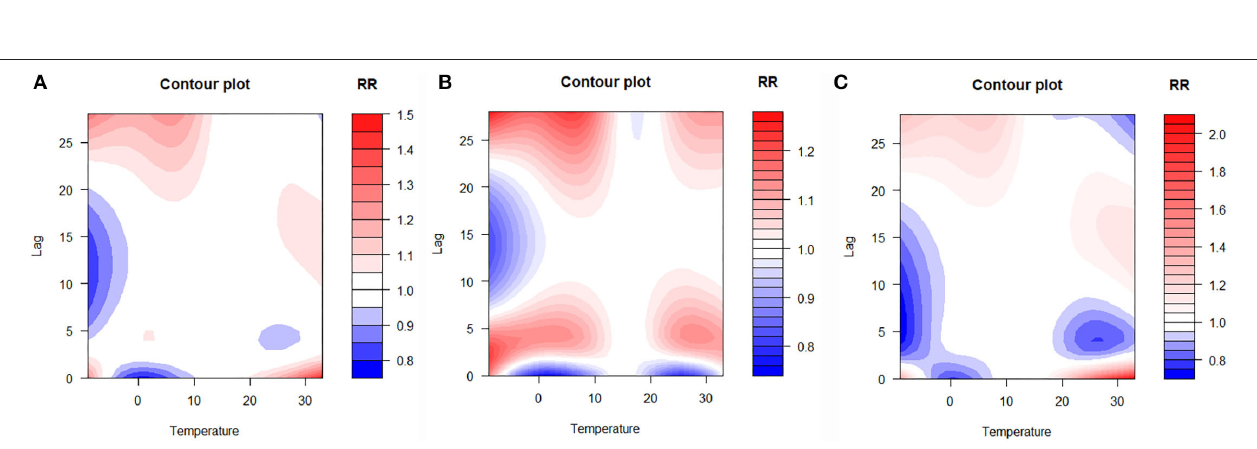
FIGURE 5 | Contour plot of lag–response about temperature on hospitalization [ (A) whole; (B) men; (C) women]. RR, relative risk.